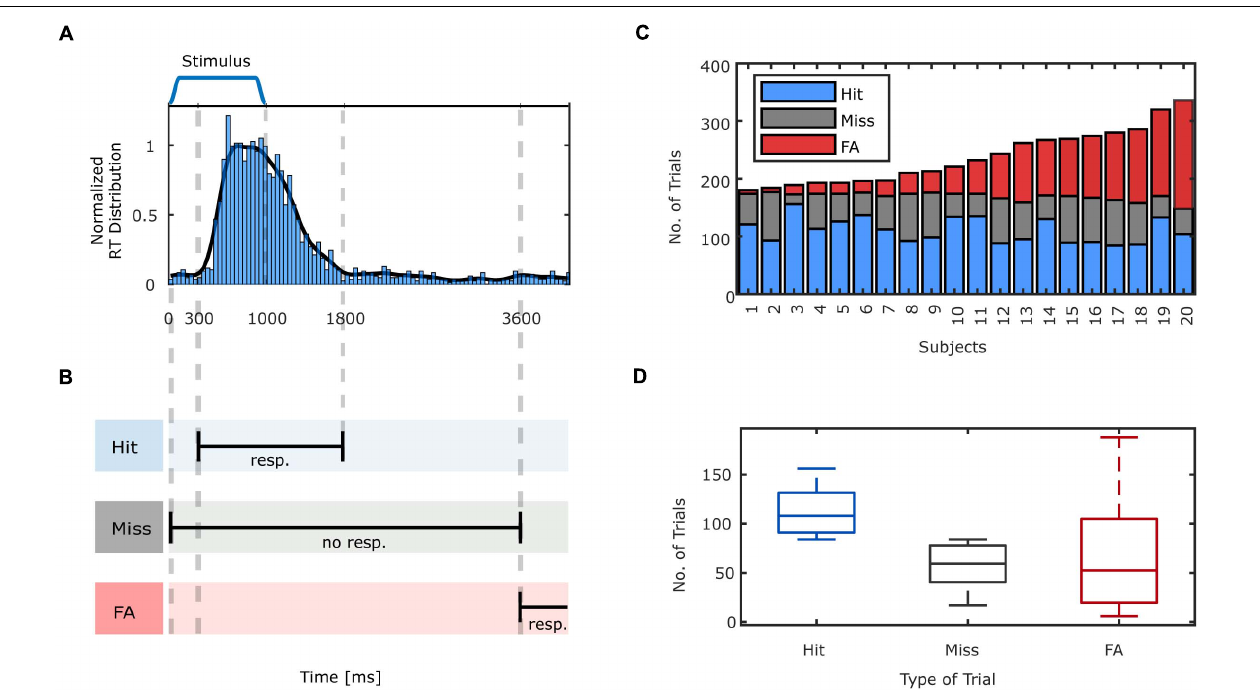
FIGURE 2 | (A) The reaction time (RT) histogram, normalized to produce an estimation of the probability density function (PDF) and Gaussian smoothed distribution for all subjects relative to stimulus presentation. (B) Criteria for categorizing the trials. A hit is identified when a response is given to a stimulus in the time interval between 300 and 1,800 ms. If no response is given to the stimulus up to 3,600 ms, this trial is labeled as a miss. Responses that occur in a time window lasting from 3,600 ms after stimulus presentation until the onset of the next stimulus denote FA trials. (C) The number of hits, misses and FAs across the subjects. (D) The box plot of the number of hits, misses and FAs for all subjects. On each box, the central mark indicates the median, and the bottom and top edges of the box indicate the 25th and 75th percentiles, respectively. The whiskers extend to the most extreme data points not considered